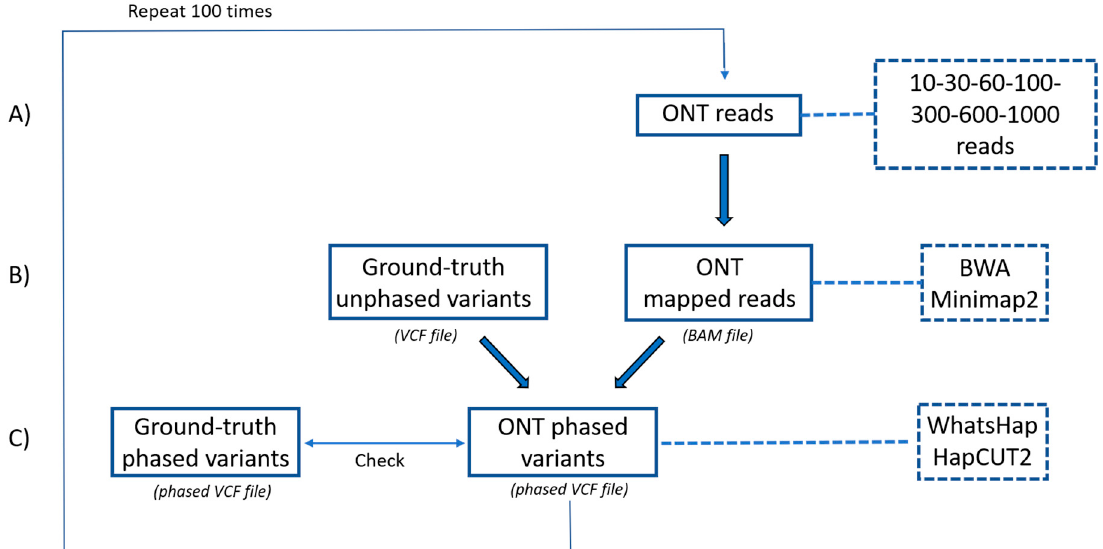
Figure 5. Experimental pipeline to assess the performance of alignment and phasing software. ( A ) Sets ranging from 10 to 10,000 ONT reads were considered. ( B ) Variants in the region of interest were identified using the highly accurate Illumina platform and stored in a VCF file (ground-truth unphased variants). ONT reads were mapped to the reference sequence using either BWA or Minimap2,